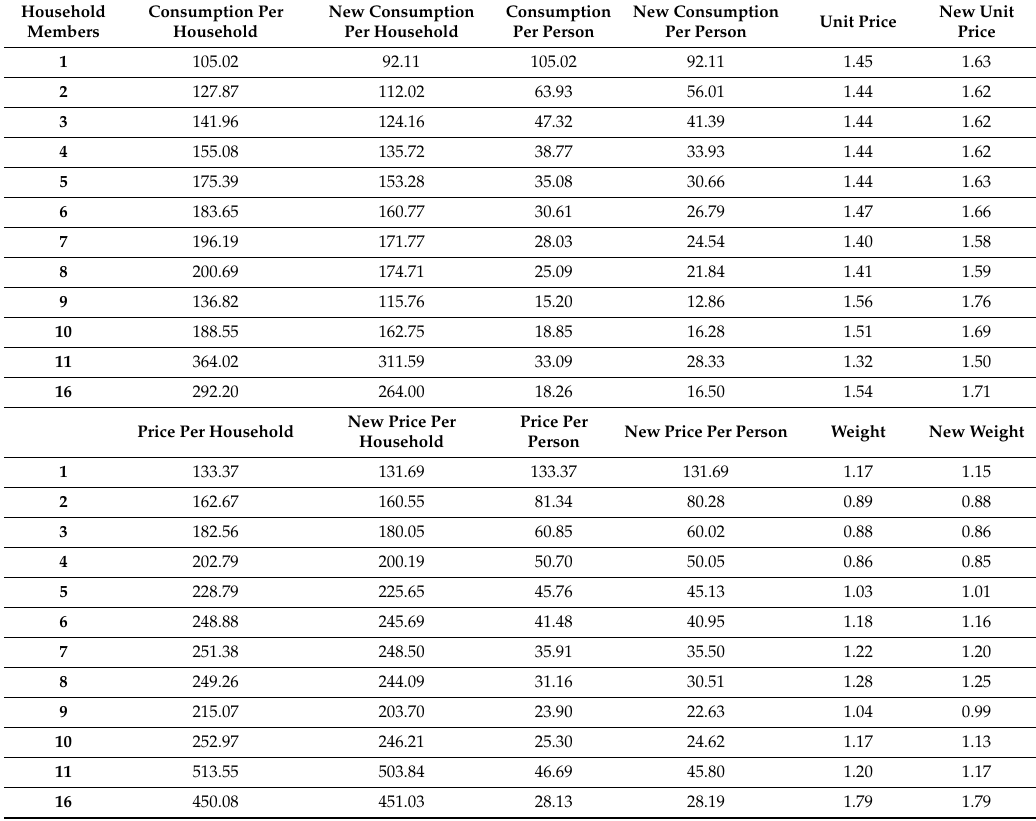
Table A3. Values before and after the Price Variation Introduced by Household